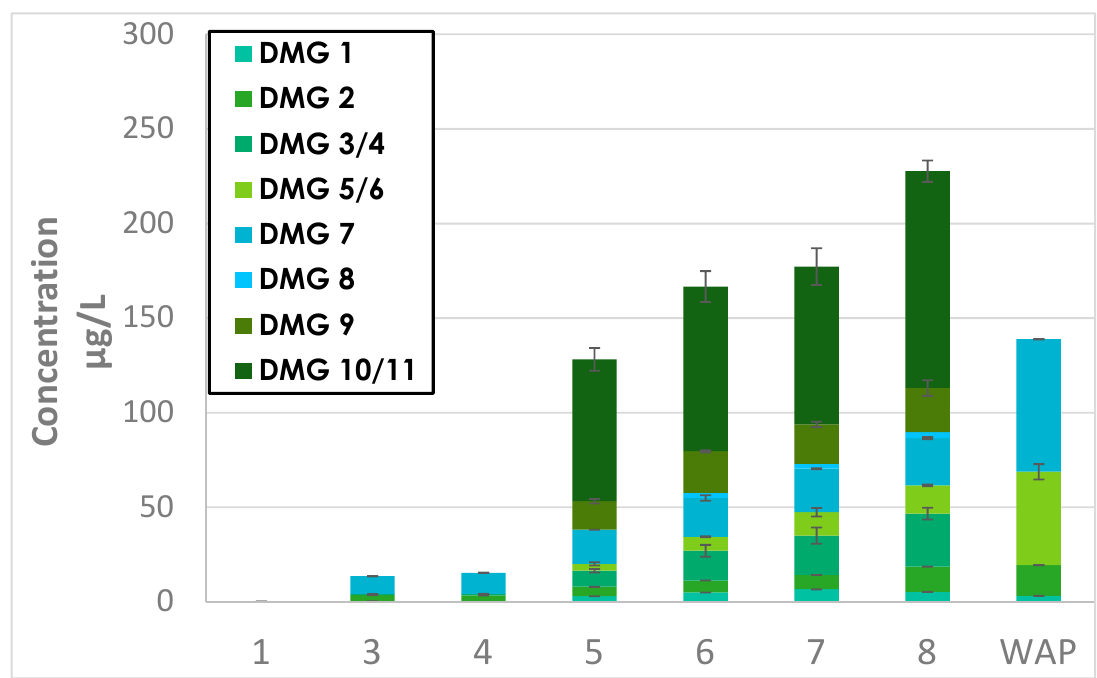
Figure A2. Evolution of DMG isomers during Syrah fermentation.